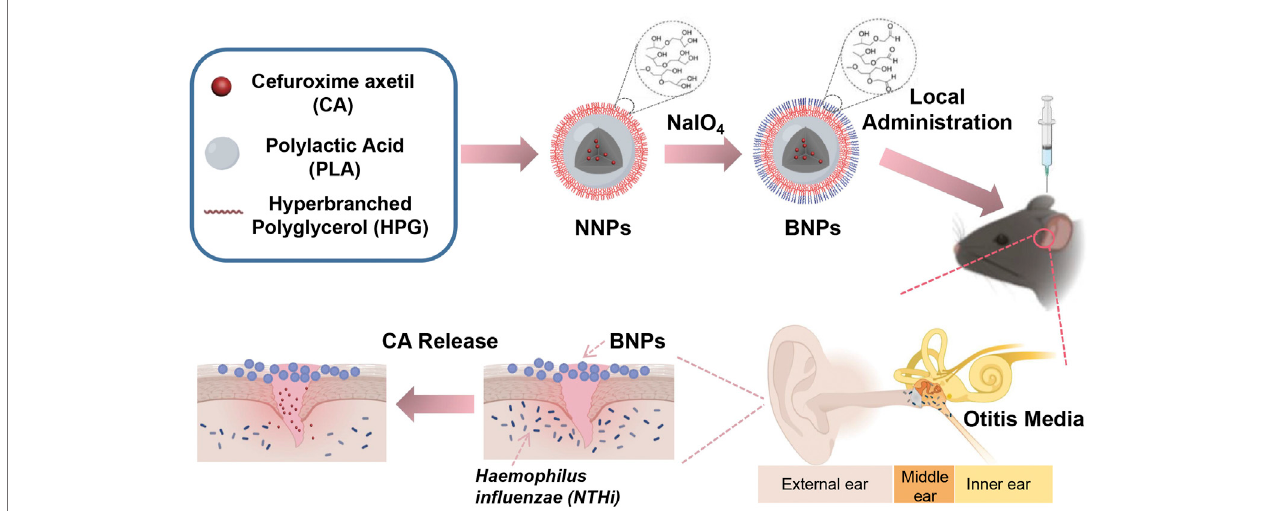
FIGURE 1 | Nanoparticle design and therapeutic effects. Schematic showing the conversion process of NNPs into BNPs, in which vicinal diols on the surface of NPswereoxidizedbysodiumperiodateintoaldehydes.ThisprocessmadeBNPshaveanadditionalbioadhesive.Theyadheredtotheepithelialsurfaceofthemiddleear so that could prolong the retention exerting bacteriostatic effect ef fi